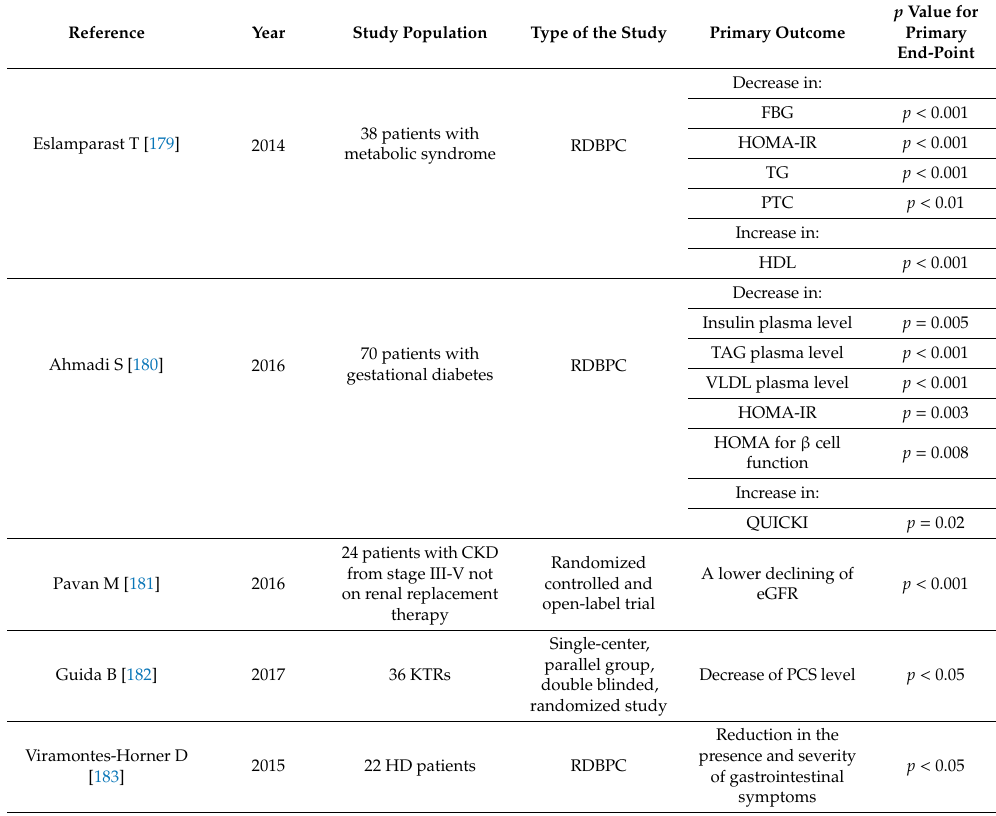
Table 3. Synbiotic e ff ects on CKD, DM and